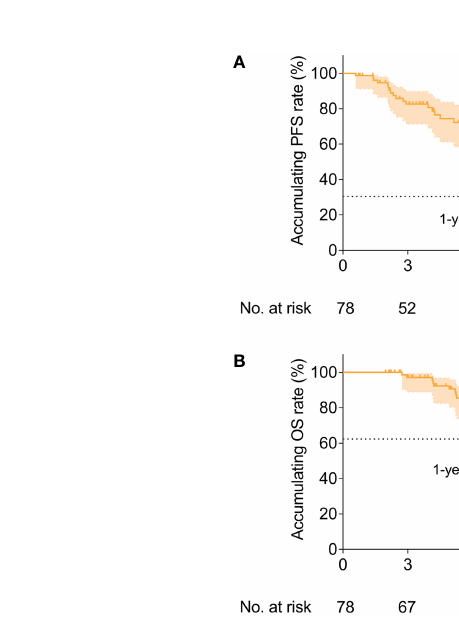
FIGURE 3 Survival pro fi les. The PFS (A) and OS (B) in HCC patients receiving camrelizumab plus TACE. HCC, hepatocellular carcinoma; TACE, transarterial chemoembolization; PFS, progression-free survival; OS, overall survival; NR, not